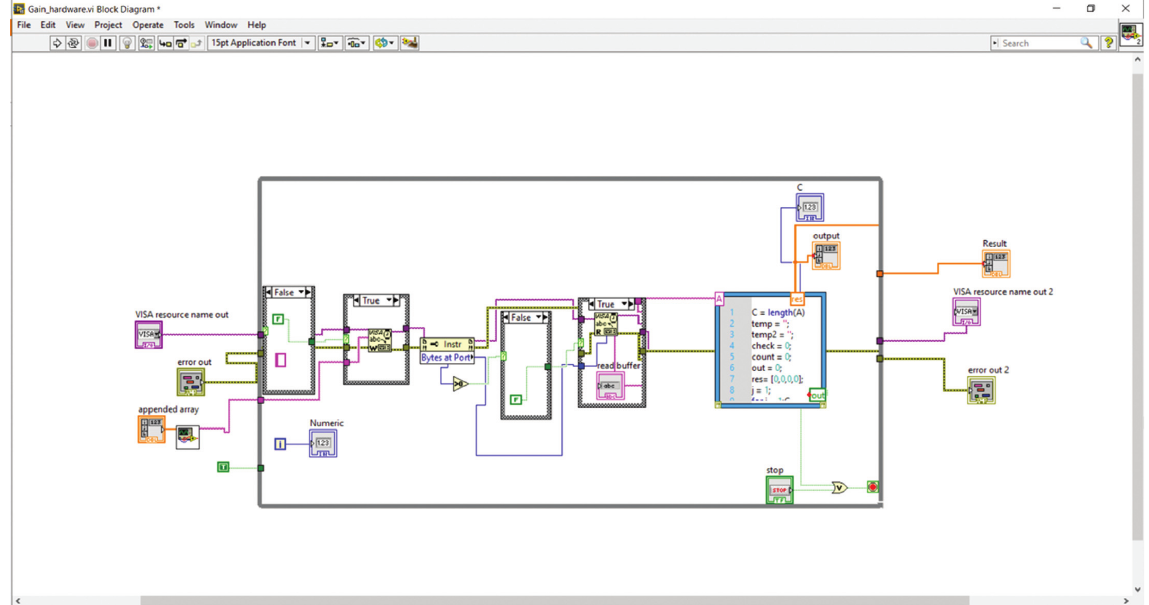
Figure 9: myRIO Serial Receiving and conversion from ASCII to Float